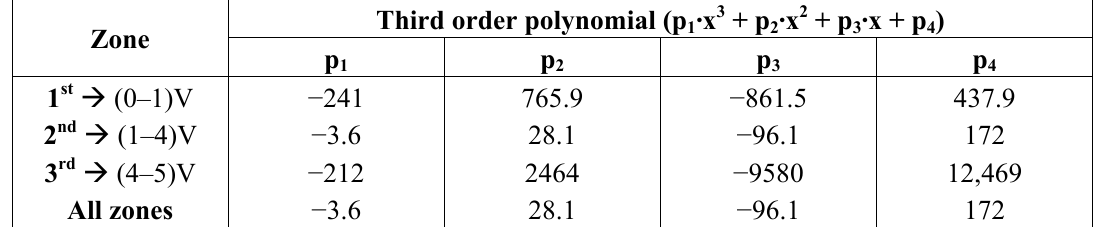
Table 4. Curve fitting coefficients for the temperature signal conditioning circuit.